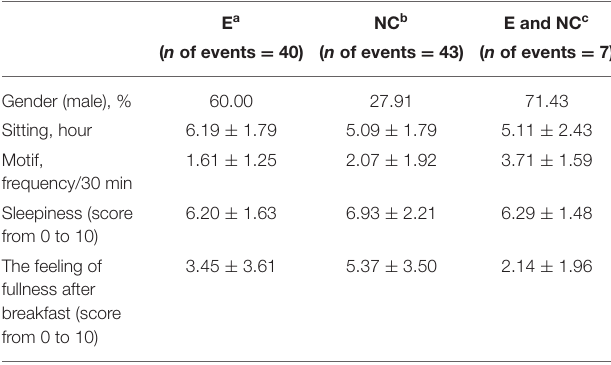
TABLE 1 | Demographic characteristics.